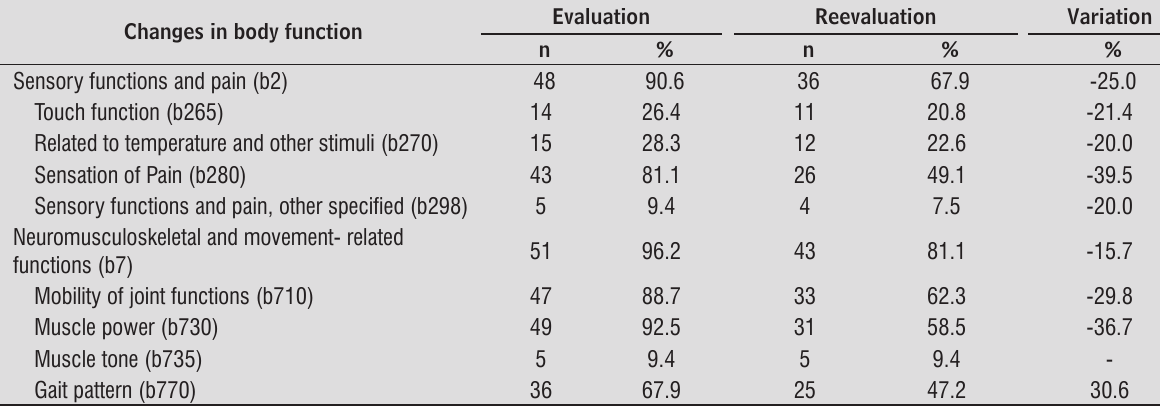
Table 1 - Distribution of changes in body function in victims of traffic accidents on initial evaluation and on reevaluation (N = 53). Cuiabá/MT, 2010 Evaluation Reevaluation Variation Changes in body function n %